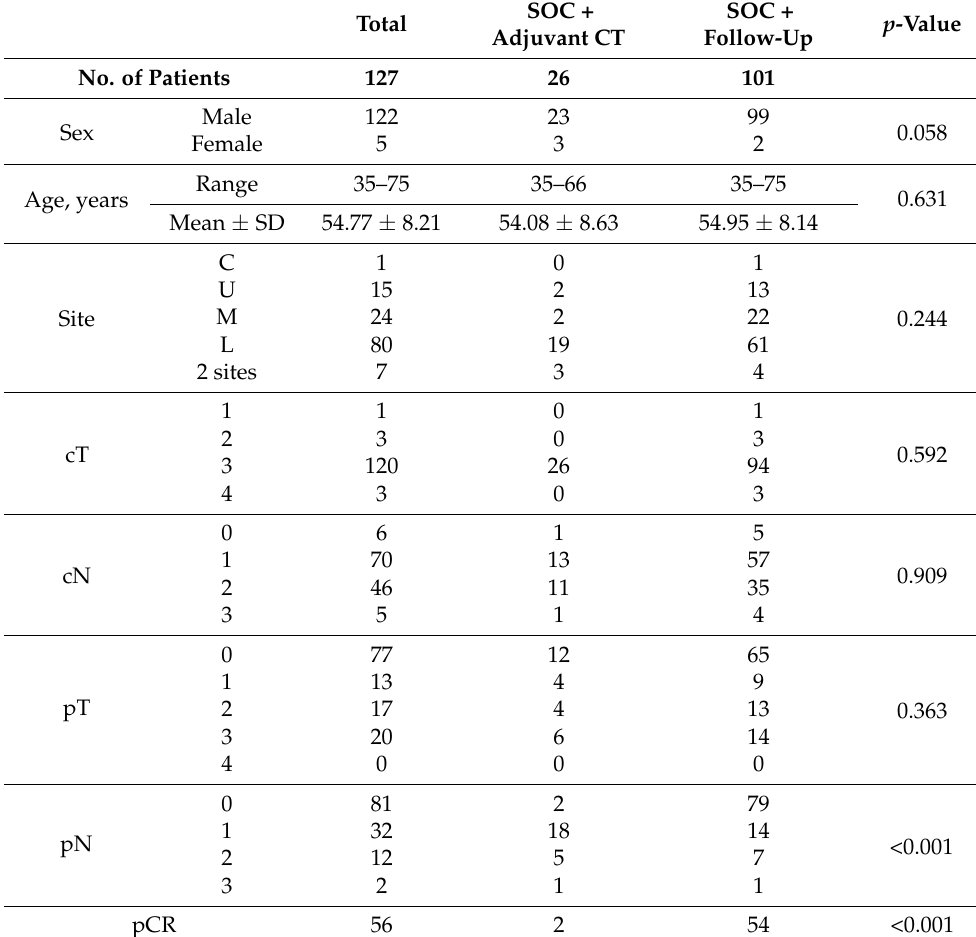
Table 1. Patients’